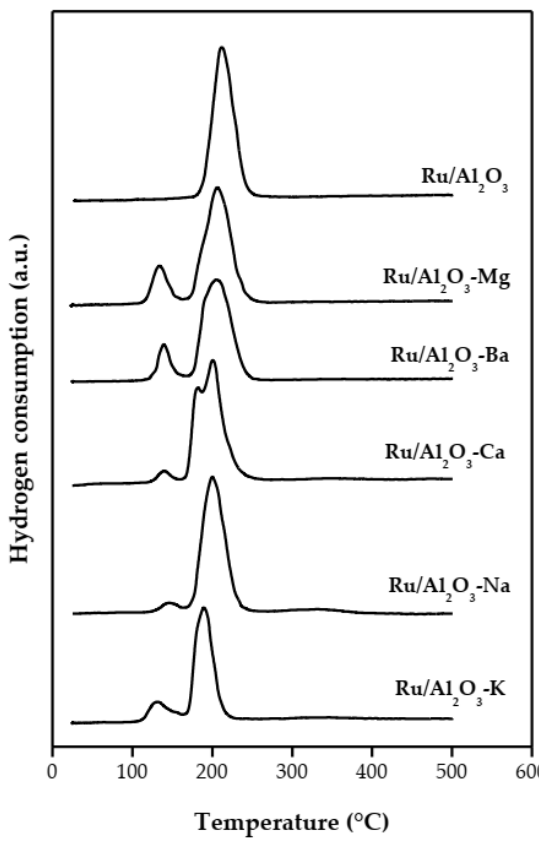
Figure 1. TPR profiles of Ru/Al 2 O 3 -A/AE(1 wt%) catalysts.